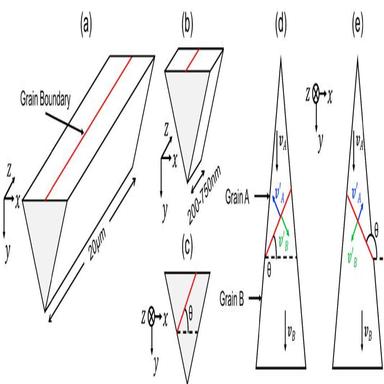
Schematic diagrams showing (a) grain boundary contained along the length of a lift-out bar. (b) Thinned section of the lift-out bar containing a grain boundary. (c) Location of grain boundary beneath the upper surface of the lift-out bar. (d) and (e) show the vectors which describe the crystallographic directions, vA and vB, that correspond to the y-axis in the TKD map in Grains A and B. The grain boundary normals (v'A and v'B) in Grains A and B for 0 90 < and 90 180 < < and for are also shown.